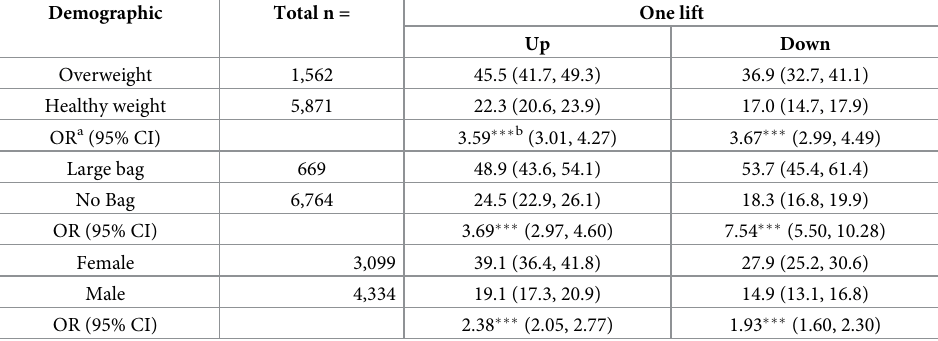
Table 4. Percentage avoidance of stairs (95% CI) outdoors, separated by direction of travel and demographic group.